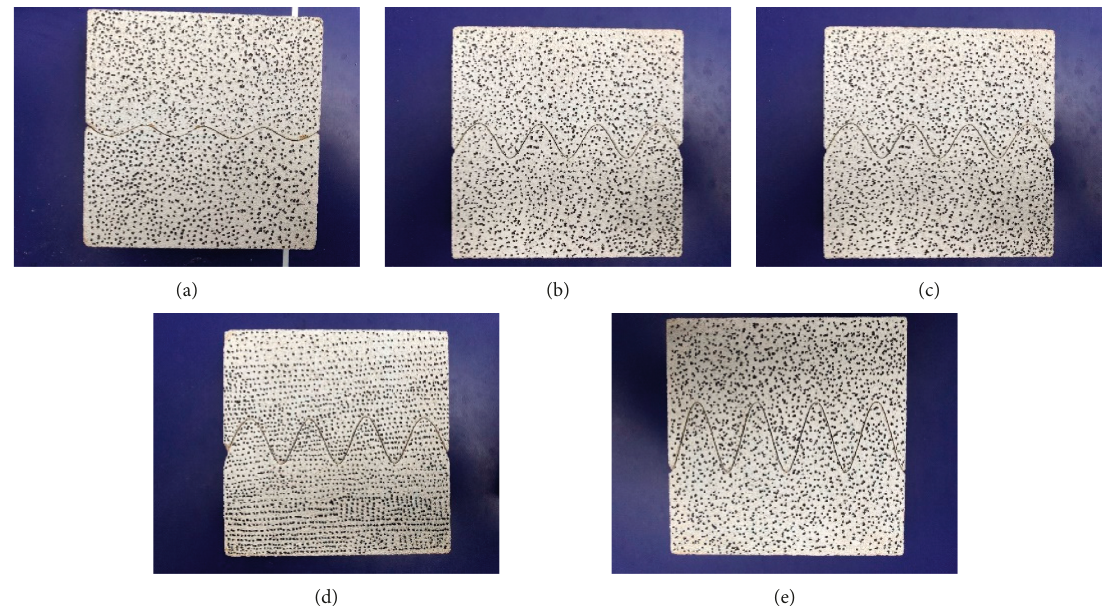
Figure 3: Specimens after marking. (a) Undulation of 5 mm. (b) Undulation of 10mm. (c) Undulation of 15mm. (d) Undulation of 20mm. (e) Undulation of 30mm.